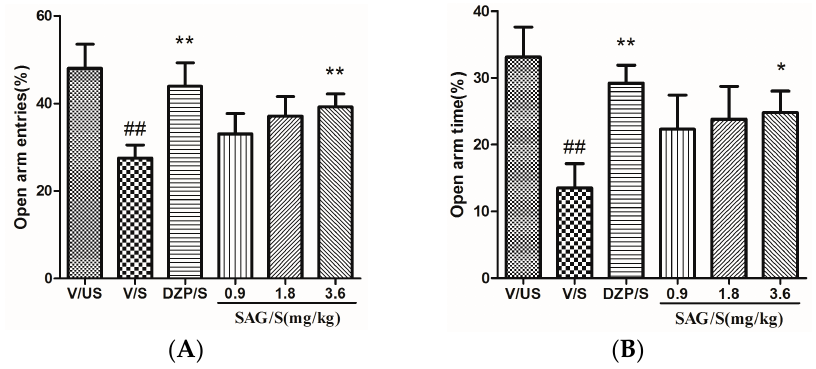
Figure 2. Effect of SAG on the open arm entries and the percentage of time spent in open arms in the elevated plus maze in rats. ( A ) Open arm entries; ( B ) Percentage of time spent in open arms. Bars represent mean ± SEM. ## p < 0.01 vs. vehicle/unstressed group; * p < 0.05 or ** p < 0.01 vs. vehicle/stressed group. One-way ANOVA with Student-Newman-Keuls post hoc test.